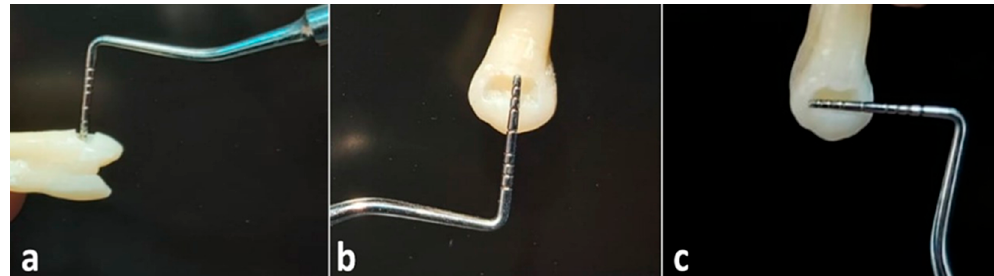
Figure 1. The dimensions of Class V cavity, ( a ) depth, ( b ) height, ( c ) length. Table 1. Composition of Filtek Z250 and Omnichroma Composites. Filtek Z250 Composite Omnichroma Composite